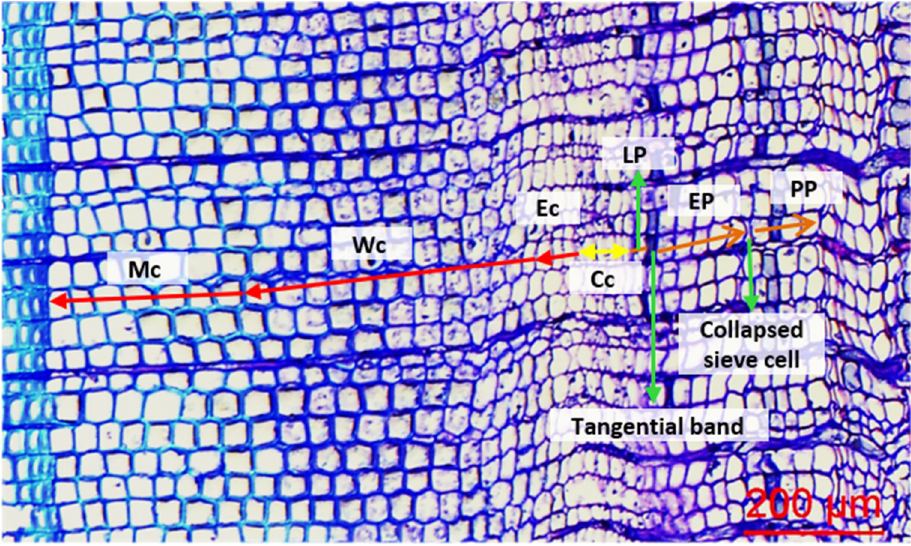
Figure 1. The radial anatomical structure of a growing tree ring of Picea crassifolia . Cc represents cambial cells; Ec, Wc, and Mc are xylem cells on various stages of differentiation, representing enlarging, wall thickening, and mature cells, respectively. EP, LP, and PP represent early phloem, late phloem, and previous-year phloem sieve cells, respectively.